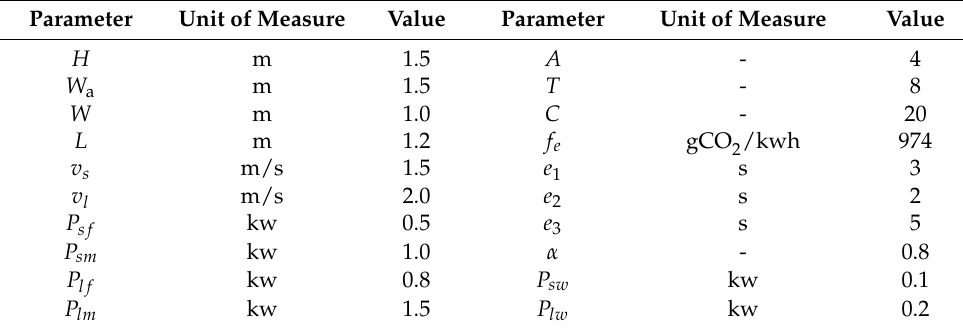
Table 2. Parameters value used in the optimization.